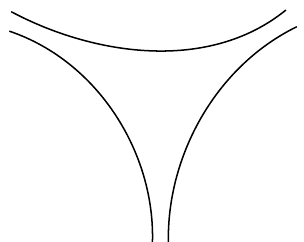
Figure 16. In the limit that the coupling goes to zero, the only surviving Feynman diagram is the one without any